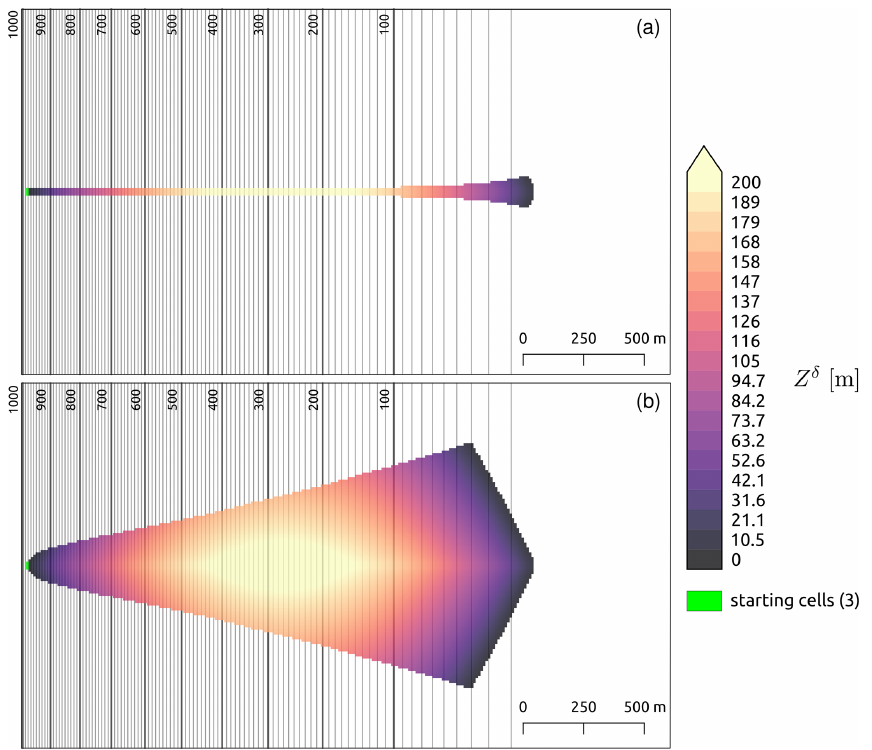
Figure 3. GMF runout modeled with Flow-Py on a simple parabolic slope connected to a flat plane with the runout angle α = 25 ◦ . The divergence control is exemplified with a low spreading ( a , exp = 100) and a high spreading ( b , exp = 8) simulation. Both examples use a = 8849m (the height of Mount Everest, i.e., no effective limit is used). Cooler colors indicate areas flux cutoff of R stop = 3 × 10 − 4 and Z δ lim where the process has a relatively low intensity with regards to Z δ max , and warmer colors show areas where the process has a relatively high intensity with regards to Z δ max , which is associated with maximum kinetic energy.